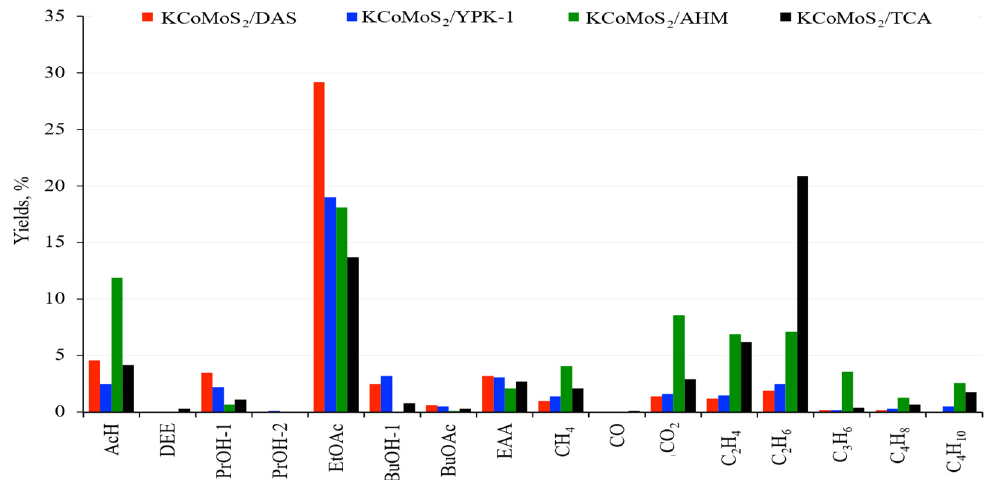
Figure 5. Product yields over KCoMoS 2 catalysts on various supports under the standard conditions. Reaction conditions: T = 320 °C, P = 2.5 MPa, m cat = 3 g, GHSV = 760 L h –1 kg cat–1 , and feed flow rate = 0.3 mL/min under He.